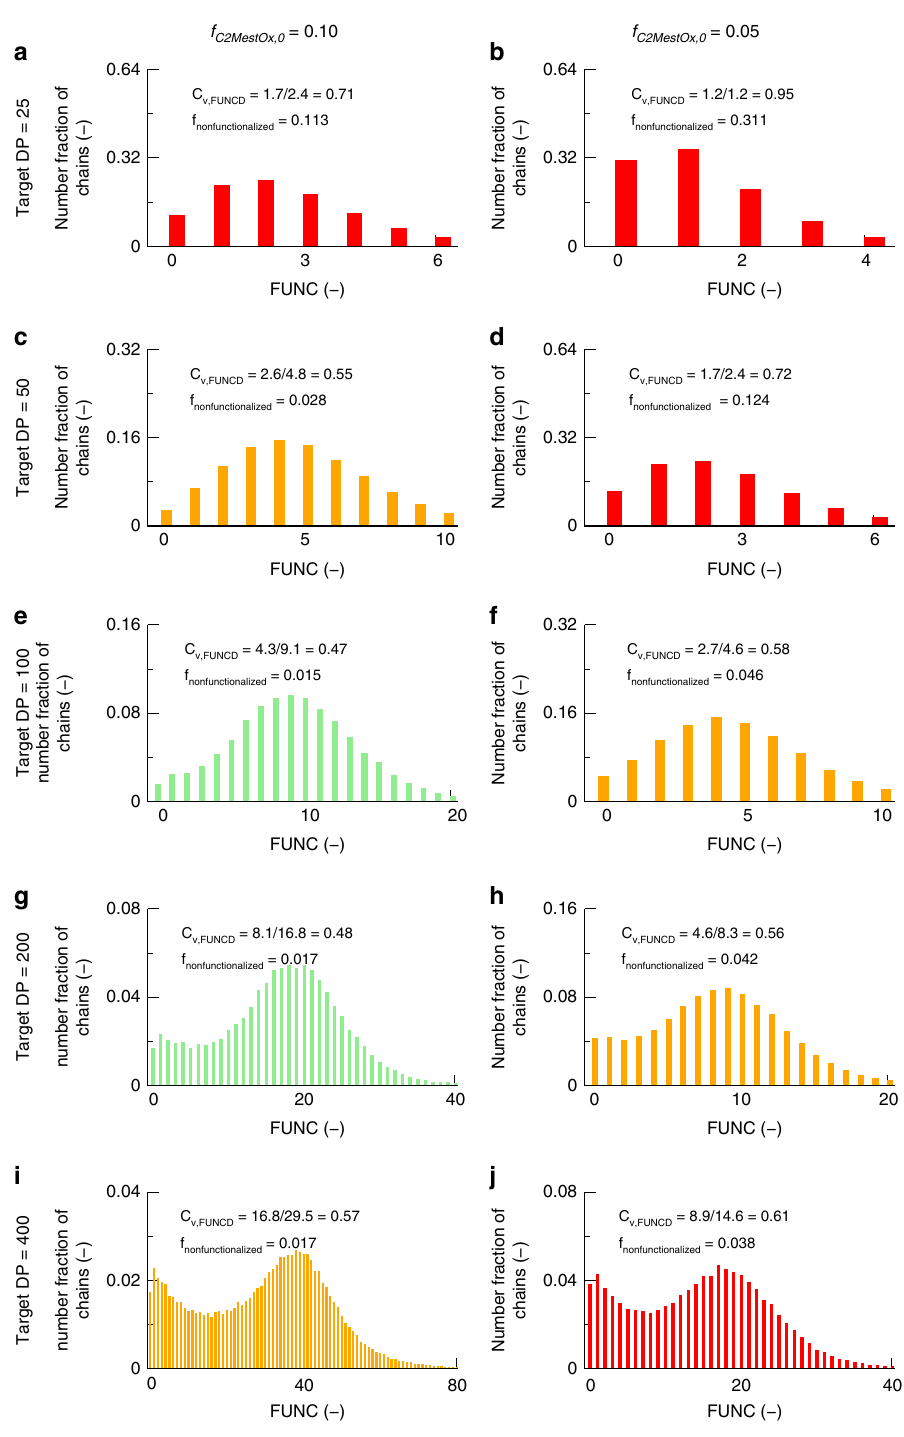
Fig. 8 Relation reaction conditions and functionality control. Effect of initial functional comonomer amount (columns; 10 ( a , c , e , g , i ) and 5 % ( b , d , f , h , j )) and target DP (rows; 25 ( a , b ), 50 ( c , d ), 100 ( e , f ), 200 ( g , h ), and 400 ( i , j )) on the functionality distribution (FUNCD) for CROP of MeOx and C2MestOx (total monomer concentration: 3 mol L − 1 ; solvent acetonitrile; Temperature = 140 °C; overall monomer conversion: 100%); color coding: according to Fig. 7d as visual aid; FUNCDs constructed out of FUNC-CLDs in Supplementary Fig. 17; only intermediate target DPs allow a reasonable functionalization (light green or yellow color) Fig. S17 of the Supplementary Information. The best functiona- Focusing on the comonomer pair MeOx/C2MestOx and a lization is obtained for intermediate target DPs (100 – 200), as low reaction temperature of 140 °C, Fig. 8 shows for 2 initial target DPs result in too high f nonfunctionalized and too high C v, functional comonomer amounts (5 and 10 mol %; left and right column), FUNCD at a monomer conversion of 100% for a target FUNCD values, and too high target DPs result in too high C v,FUNCD DP of 50, 100, 200, and 400 (top to bottom). These FUNCDs were values, due to chain transfer reactions, despite the excellent constructed out of the fi ngerprints, i.e., FUNC-CLDs, given in f nonfunctionalized values. NATURE COMMUNICATIONS| (2019) 10:3641